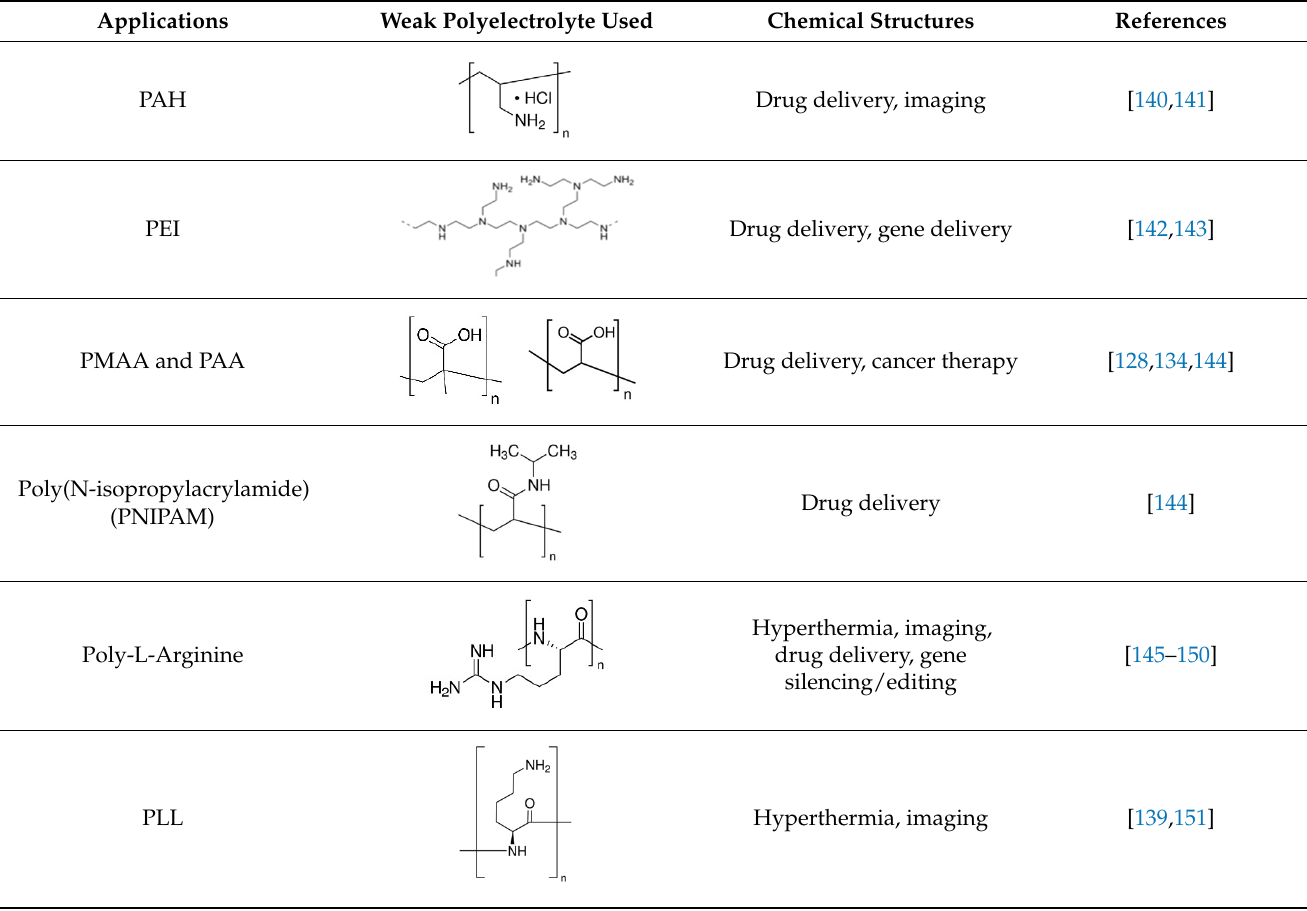
Table 5. Recently reported weak polyelectrolytes used in the development of multilayered nanocarriers and emerging applications.